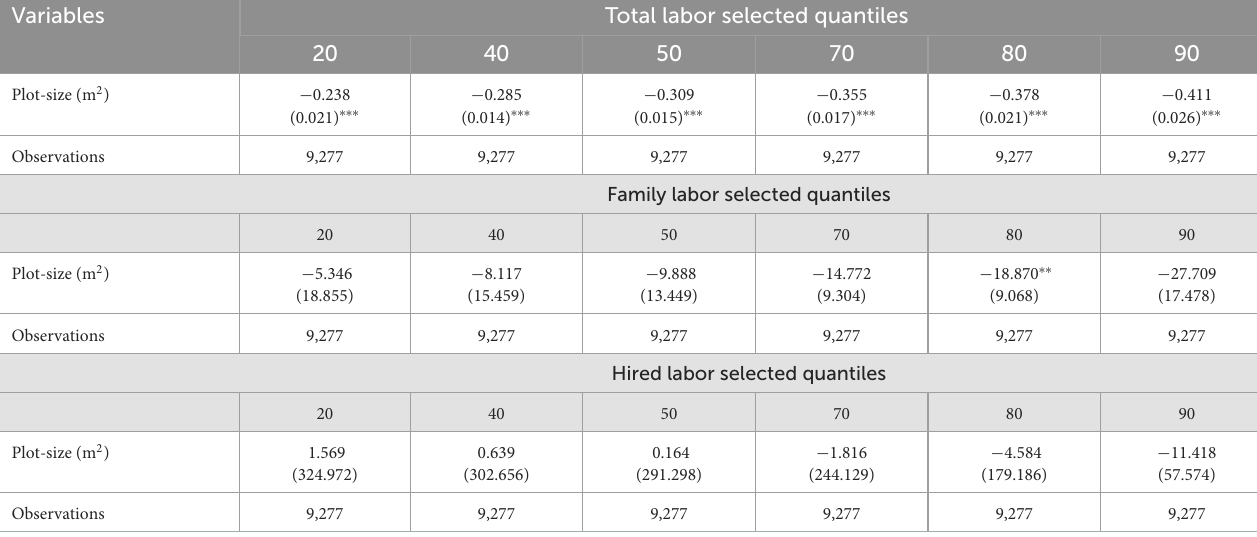
TABLE 5 Labor usage, planting season and labor category, all waves. Variables